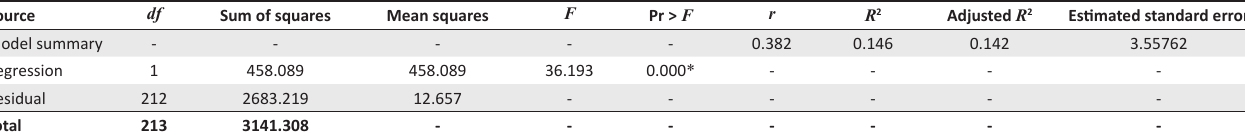
TABLE 3: Simple linear regression model fit and summary for workplace spirituality on employee physical health. Source df Sum of squares Model summary Residual